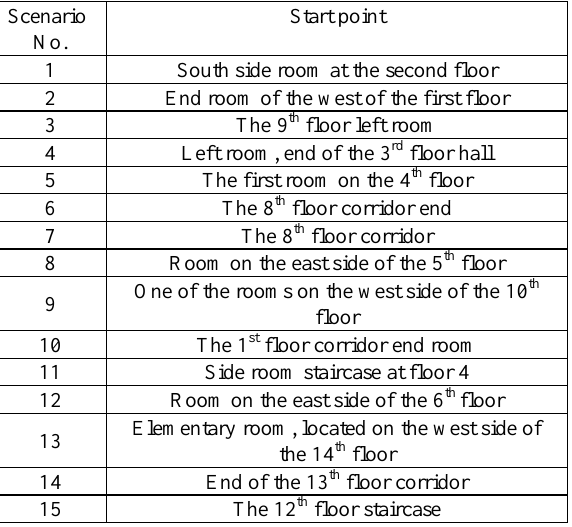
Table 1. The difference among these scenarios is at their starting points .